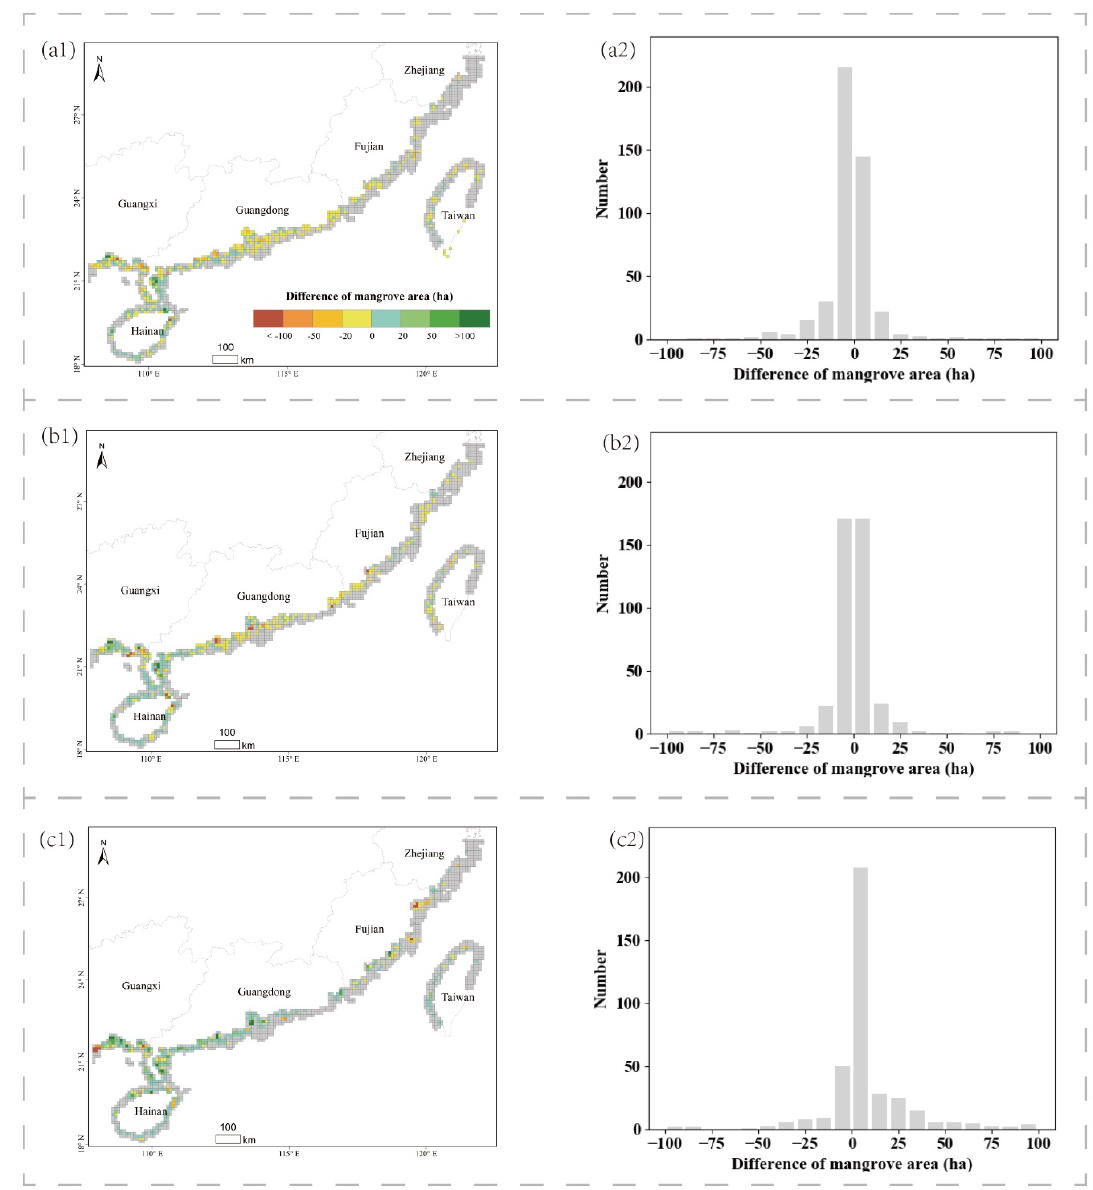
Figure 8. The spatial and number distribution of mangrove area difference between our 10-m map and existing 30-m products at a common unit of 0.1°. The grey color in a1, b1, and c1 represents a 10 km buffer zone along the coastline. ( a1, 2 ) Difference of mangrove area between 10-m result and MFM_2015; ( b1, 2 ) Difference of mangrove area between 10-m result and MFP_2015; ( c1, 2 ) Difference of mangrove area between 10-m result and GMW_2016.